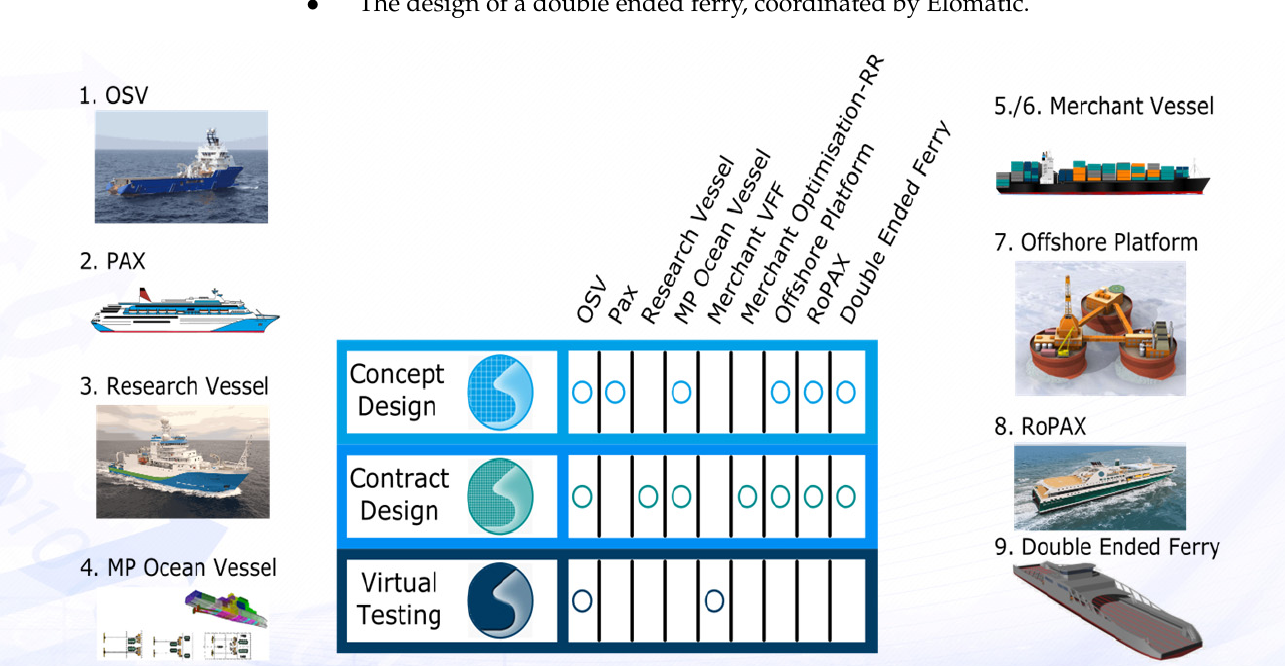
Figure 15. HOLISHIP Demonstrators.